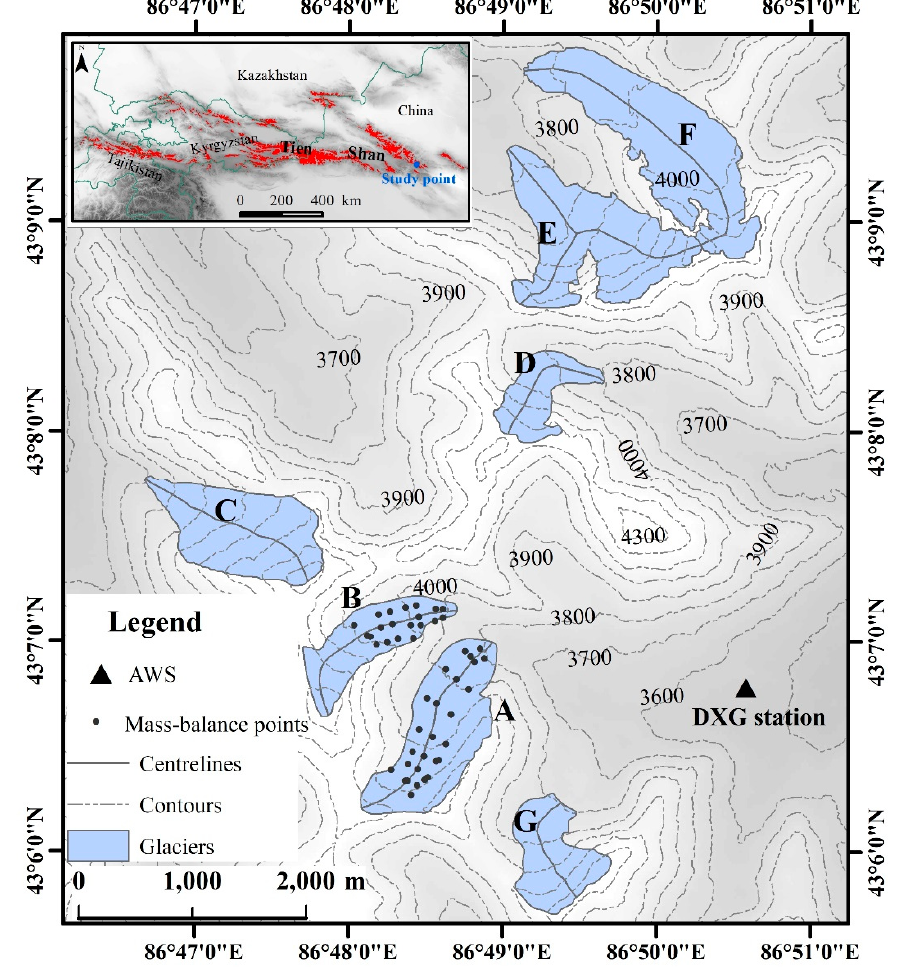
Figure 1. Geographical location of the studied glaciers. Labels correspond to glaciers in Table 1. Urumqi Glacier No. 1 (UG1), consisting of two small valley glaciers, was included in the investigated glaciers. In this study, the east branch of UG1 was labeled A, and the west branch was labeled B. Among the seven investigated glaciers, continuous long-term mass balance measurements have been carried out at Urumqi Glacier No. 1 using the glaciological method since 1959 [22]. Mass balance data and related ELAs on A and B glaciers were used to evaluate the representativeness of the end-of-summer SLA computed from the satellite images as an indicator of the ELA computed from field